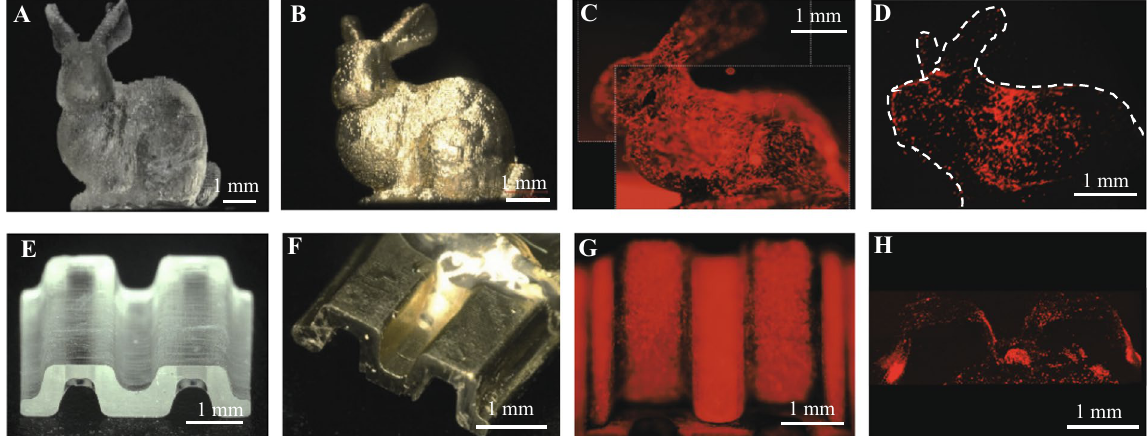
Figure 5. Cell sheets preparation on 3D molds and transfer using electrochemical cell detachment. ( A , E ) Bunny ( A ) and small intestine ( E ) molds were fabricated using micro-stereolithography. ( B , F ) The molds were coated with gold by electroless plating. ( C , G ) RFP-HNDFs were seeded on the molds. The image ( C ) was composed of two merged images indicated with white dashed squires. ( D , H ) The cell sheets were transferred to collagen gel using electrochemical cell